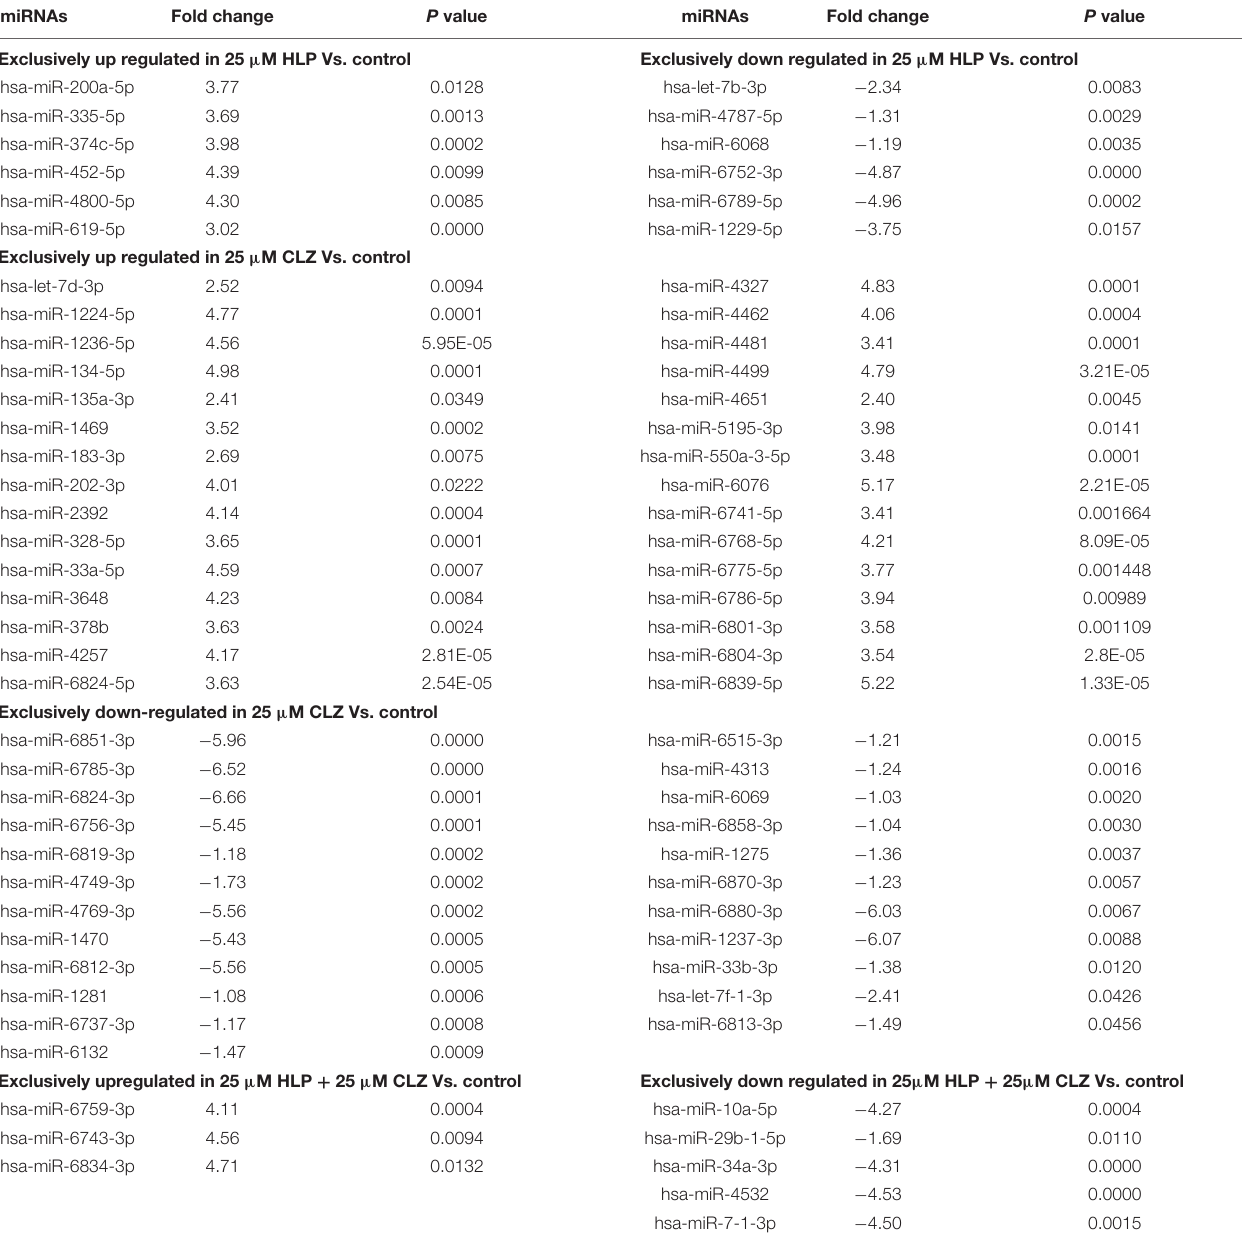
TABLE 3 | List of miRNAs exclusively but significantly altered in each antipsychotic drug treatment group. miRNAs Fold change P value miRNAs Fold change P value Exclusively up regulated in 25 µ M HLP Vs. control Exclusively down regulated in 25 µ M HLP Vs.